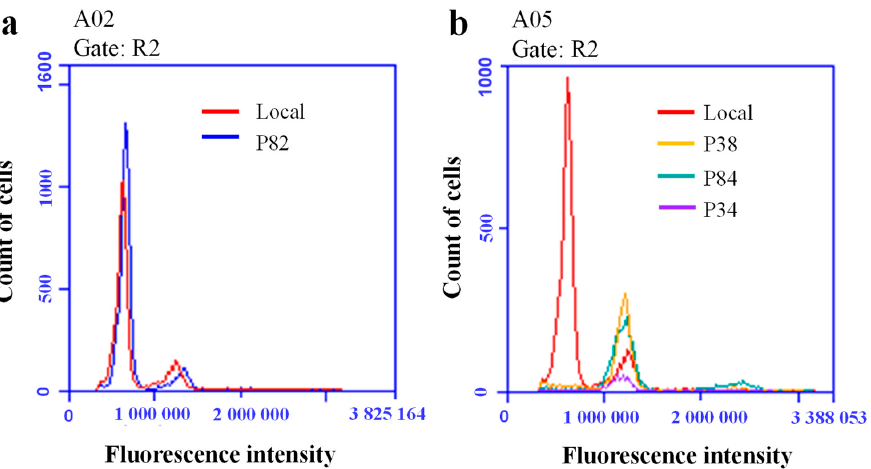
Figure 4. Comparison of DNA content in the different lines of D. latiflorus . Fluorescence intensity was indicative of DNA content. ( a ) DNA content of line P82 and Local (It is known to be hexaploid); ( b ) DNA content of lines P30, P84, P34 and Local.